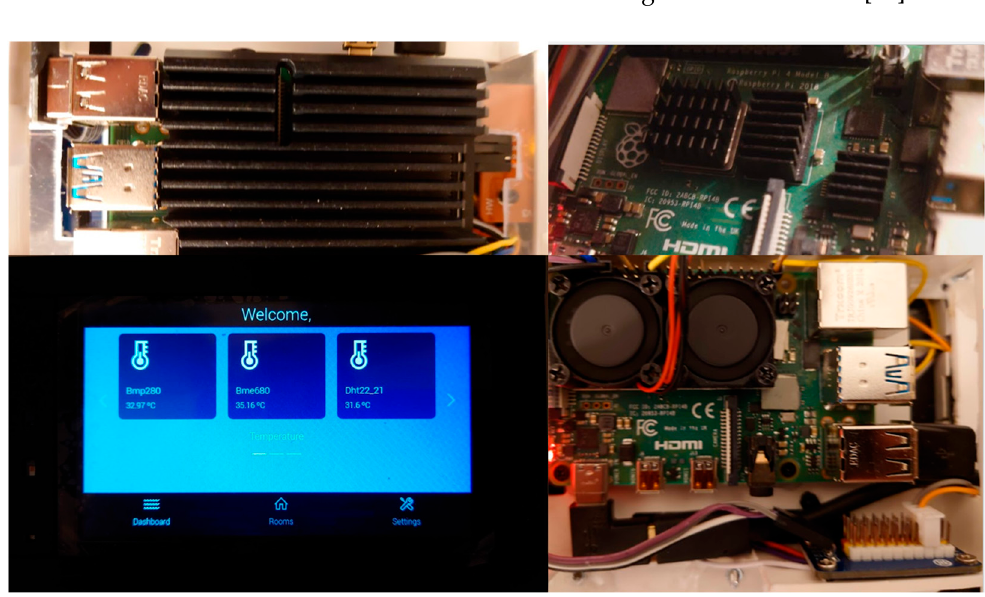
Figure 4. Example of the web interface and cooling methods for a Raspberry Pi [11].